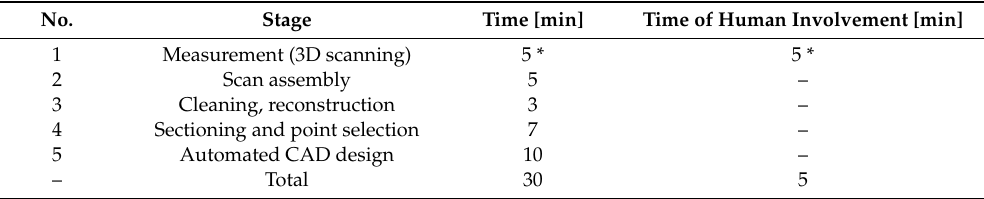
Figure 5. Automatically designed customized orthosis. ( a ) Lower part with visible grooves for assembly, ( b ) complete orthosis, juxtaposed with recreated patient’s forearm geometry. Table 1 contains summary of time of orthosis design process using automated data processing algorithms and an intelligent CAD model. Table 1. Summary of times of orthosis